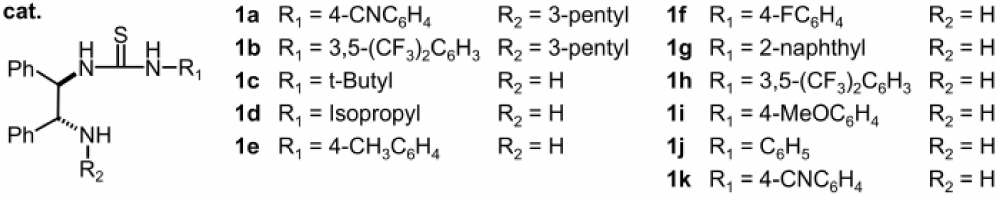
Figure 1. DPEN-thiourea based